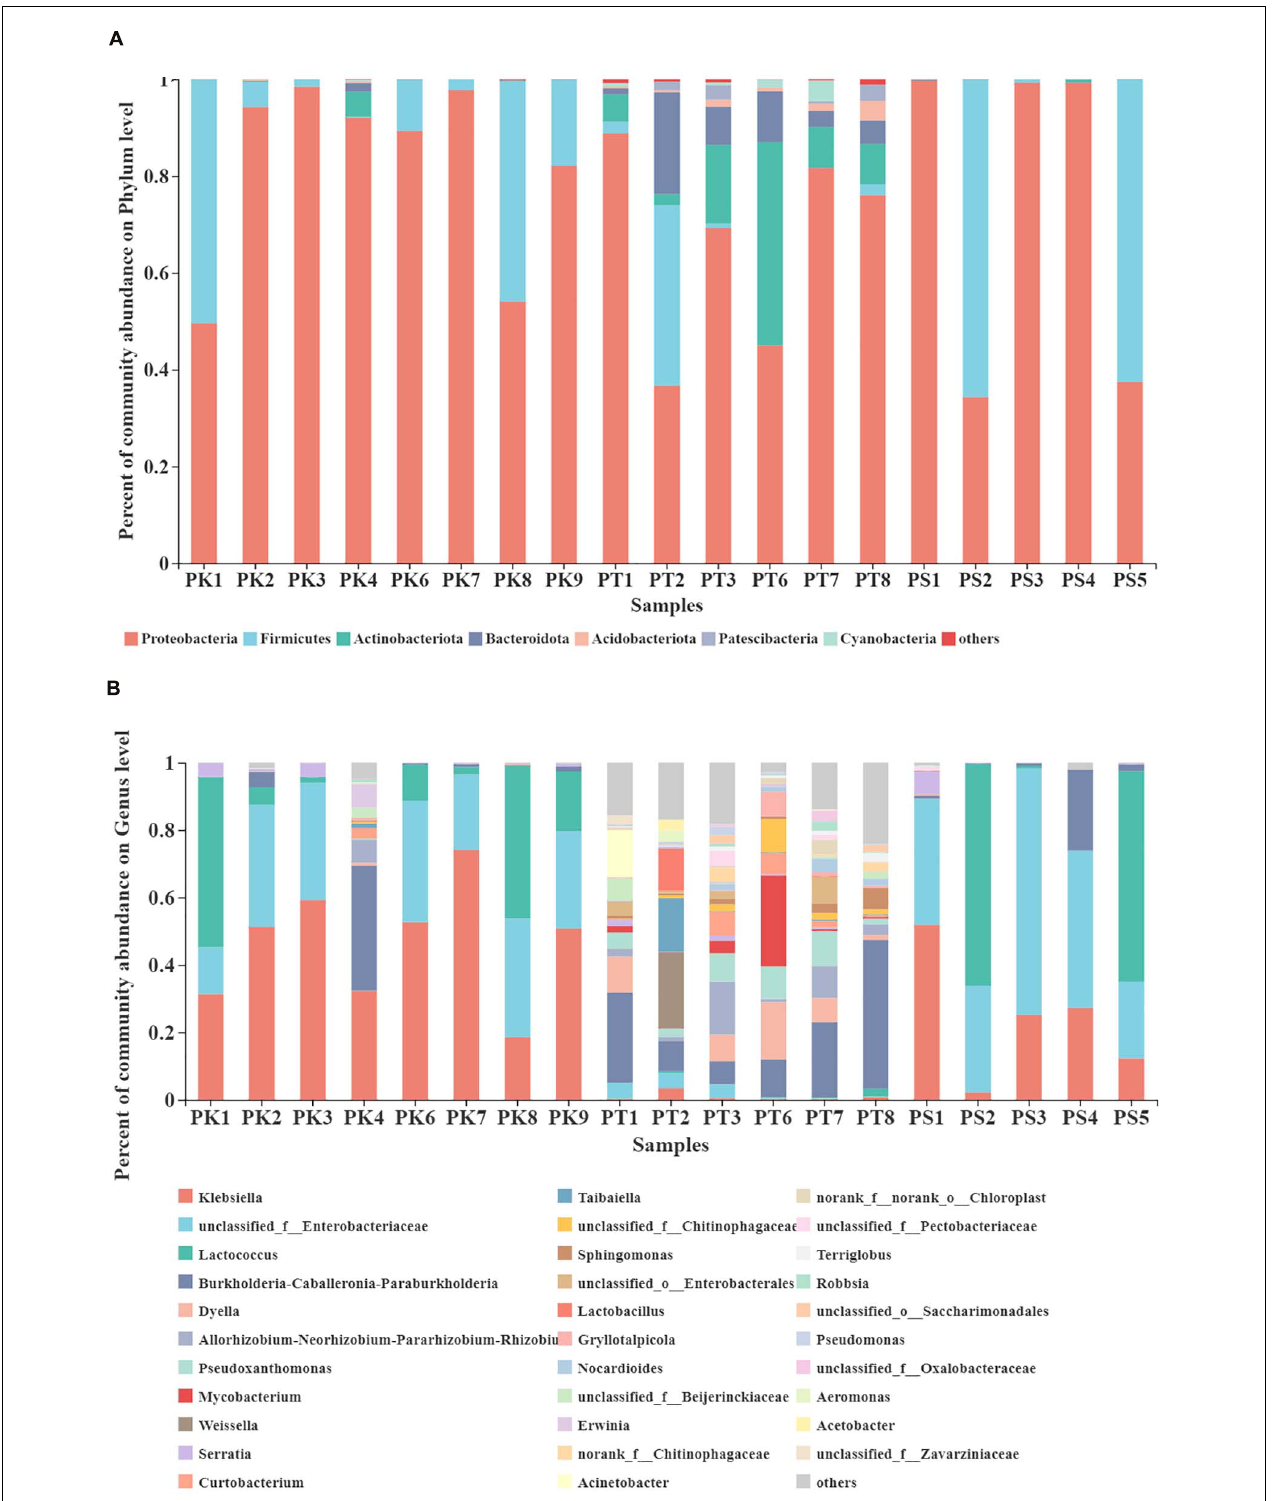
FIGURE 3 | Taxonomic composition of highly abundant bacterial phyla and genera in the gut microbiota of larvae feeding on different host trees. (A) Relative abundance of dominant microbial phyla (abundance ≥ 1%). (B) Relative abundance of dominant microbial genera (abundance ≥ 2%). The relative percent abundance of bacterial genera is represented by different